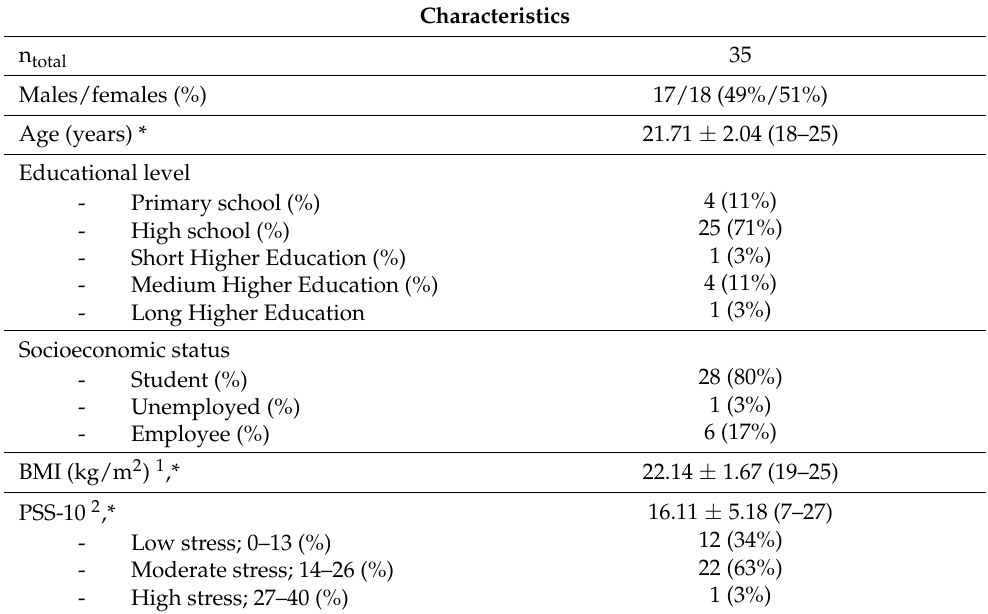
Table 1. Participant